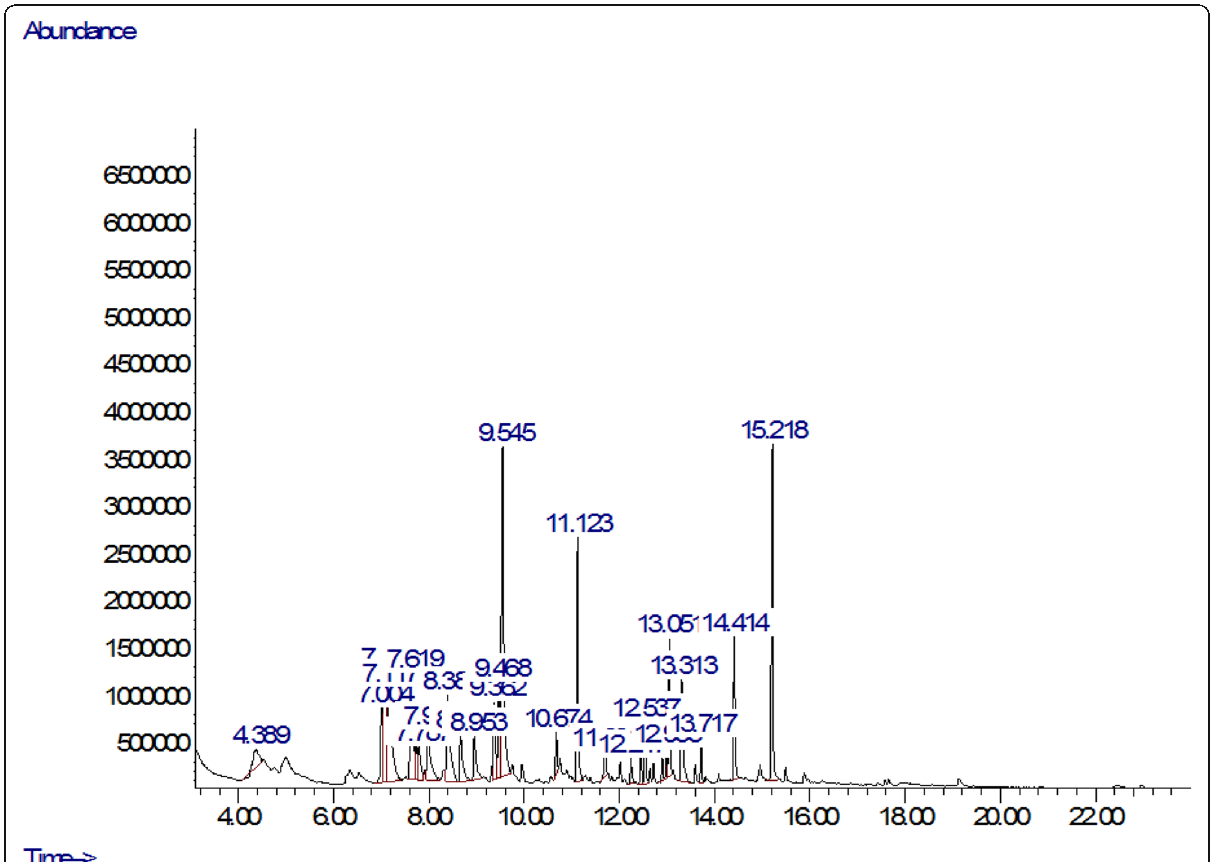
Fig. 2 GC-MS Chromatograph of A. fagellaris